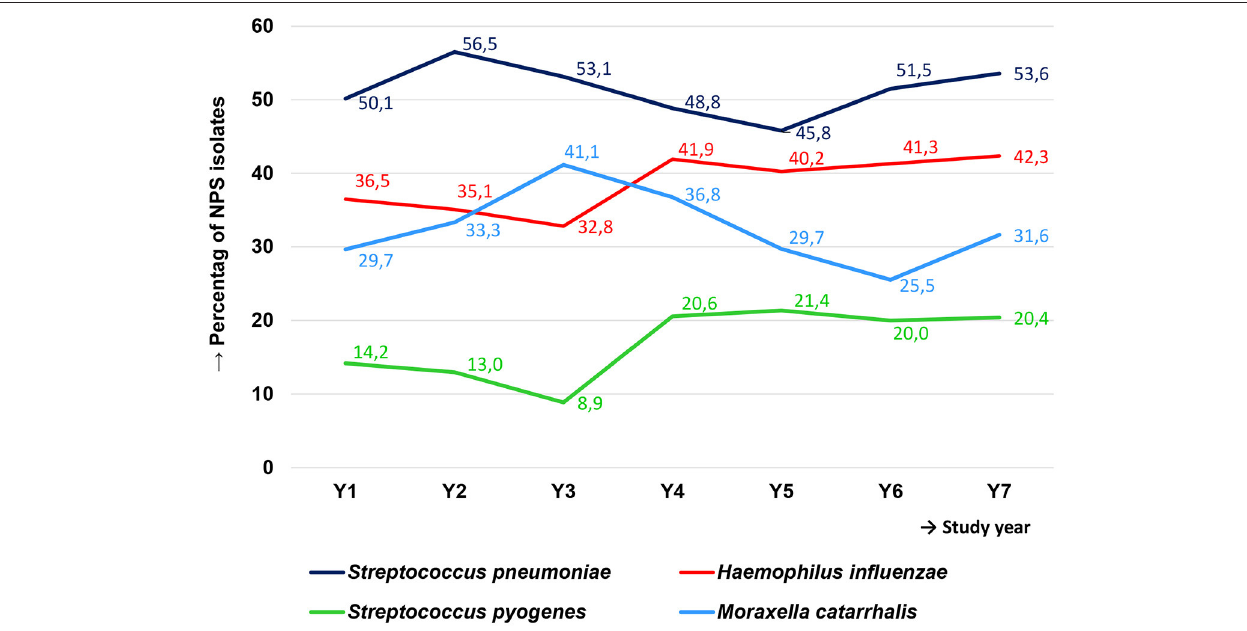
FIGURE 2 | Percentage of nasopharyngeal carriage of four relevant bacterial species among children in Germany with severe spontaneously ruptured AOM over the 7-year study period.